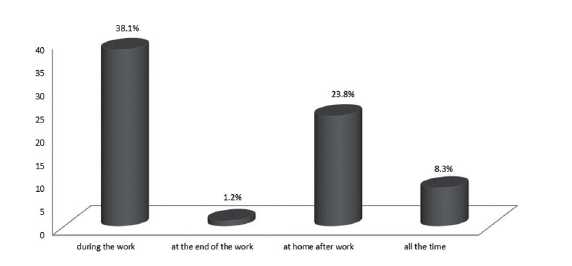
Figure 1 - The time of day when the construction workers feel back pain. São Luis – MA,